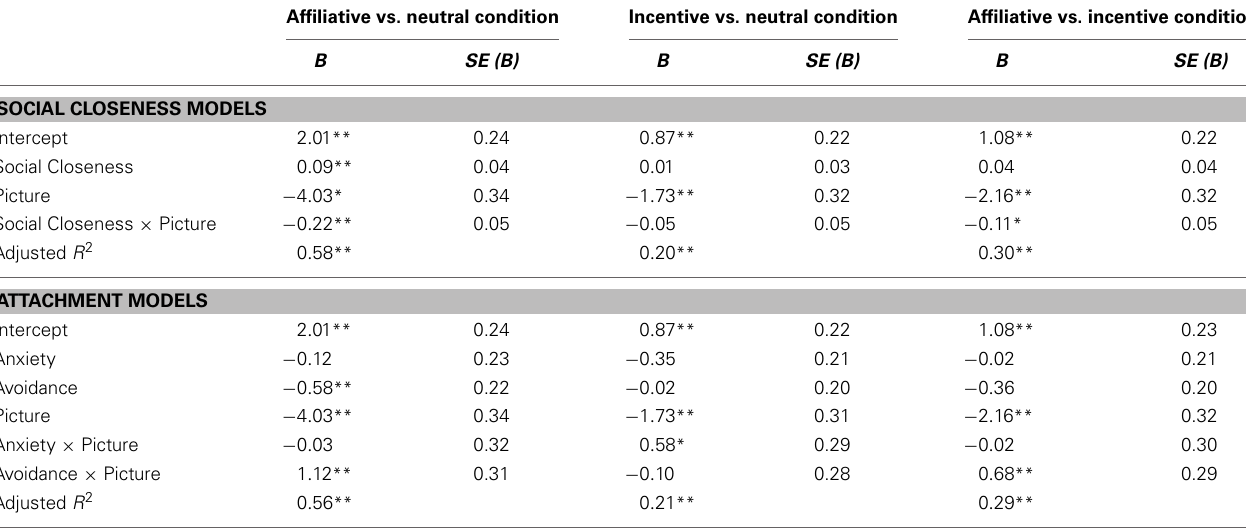
Table 3 | Repeated measures ANCOVA